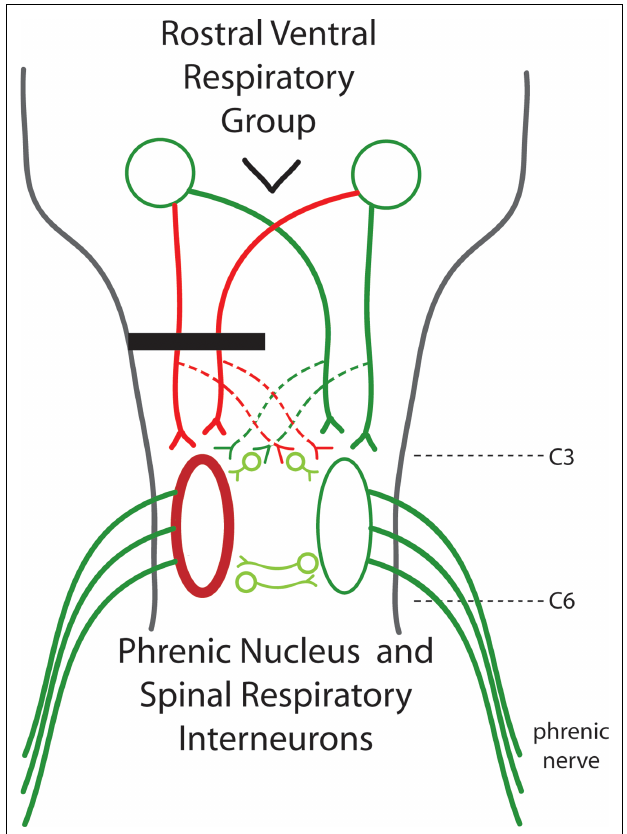
FIGURE 1 | A diagram of the respiratory pathways to the spinal cord. The phrenic nuclei are located bilaterally in the caudal C3 to rostral C6 spinal cord. The excitatory inspiratory drive comes from the rostral ventral respiratory group located in the medulla. Axons from the RVRG can decussate in the medulla to bilaterally innervate the phrenic nuclei. C2 hemisection (black bar) results in unilateral disruption of RVRG-spinal pathways (red lines) and quiescence of the ipsilateral phrenic nerve leading to paralysis of the ipsilateral hemidiaphragm. The crossed phrenic pathway (dashed lines) can circumvent the C2 hemisection by descending contralateral to the lesion and crossing over near the level of the phrenic nuclei. Normally inactive, activation of this spared pathway can restore function. It has been recently shown that spinal interneurons may play a role in this